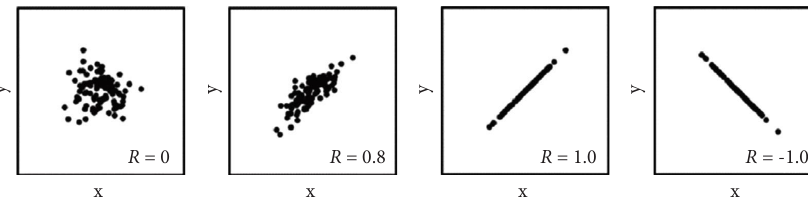
Figure 2: Sets of data generated based on correlation coefcients: R � 0, uncorrelated data; R � 0.8, strongly positively correlated; R � 1.0, perfectly positively correlated; and R � − 1, perfectly negatively correlated